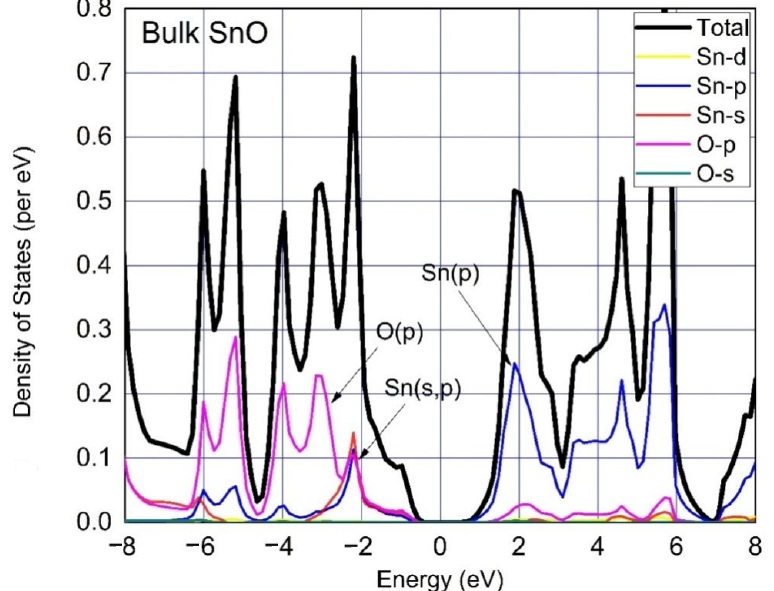
Figure 3. Total Density of States (TDOS) and Partial Density of States (PDOS) were calculated for Bulk SnO. The Fermi levels adjusted at 0 eV, whereas the colored lines represent states are per mentioned labels. There is a gap of 0.6 eV between CBM and VBM.